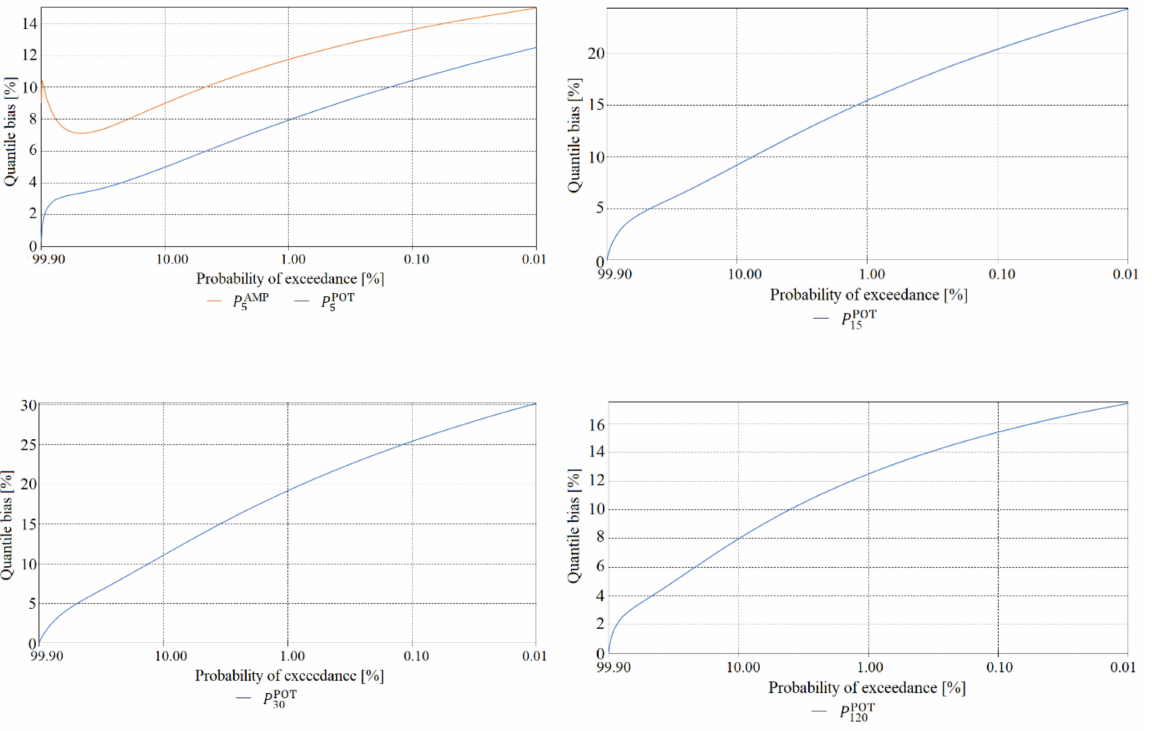
Figure 11. Comparison of estimated values of quantile error resulting from the randomness of the sample of max- imum precipitations computed using the PMAXTP model for the random variables P AMP τ and P POT τ with durations τ = {5, 15, 30, 120} min, for the Chojnice meteorological